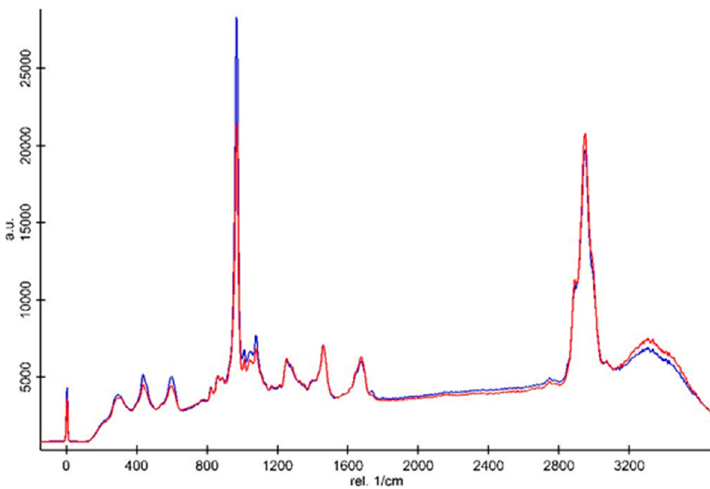
Figure 4. Representative Raman spectra of the dentin bridge of the MTA group (red line), the dentin bridge of the Biodentine™ group (blue line), and the primary dentin (green line).